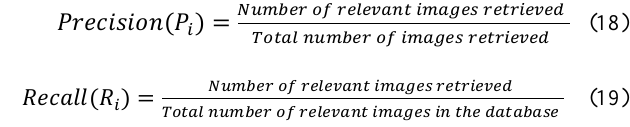
Phase 4: Similarity